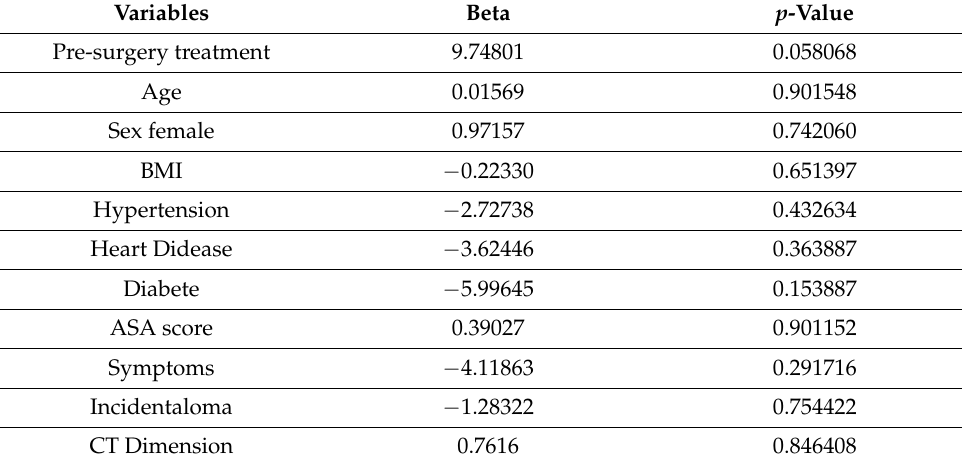
Table 3. Results for difference in diastolic blood pressure at end of surgery (multivariare analysis). Variables Beta p -Value Pre-surgery treatment